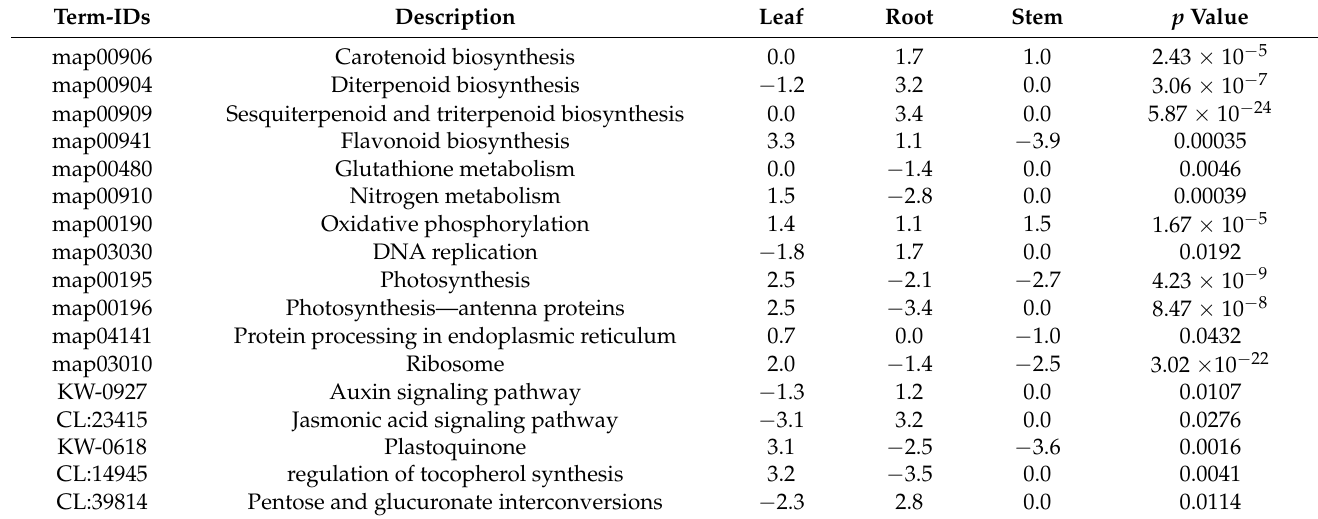
Table 2. Significantly enriched metabolic pathways in leaf, stem, and root tissues of I. racemosa